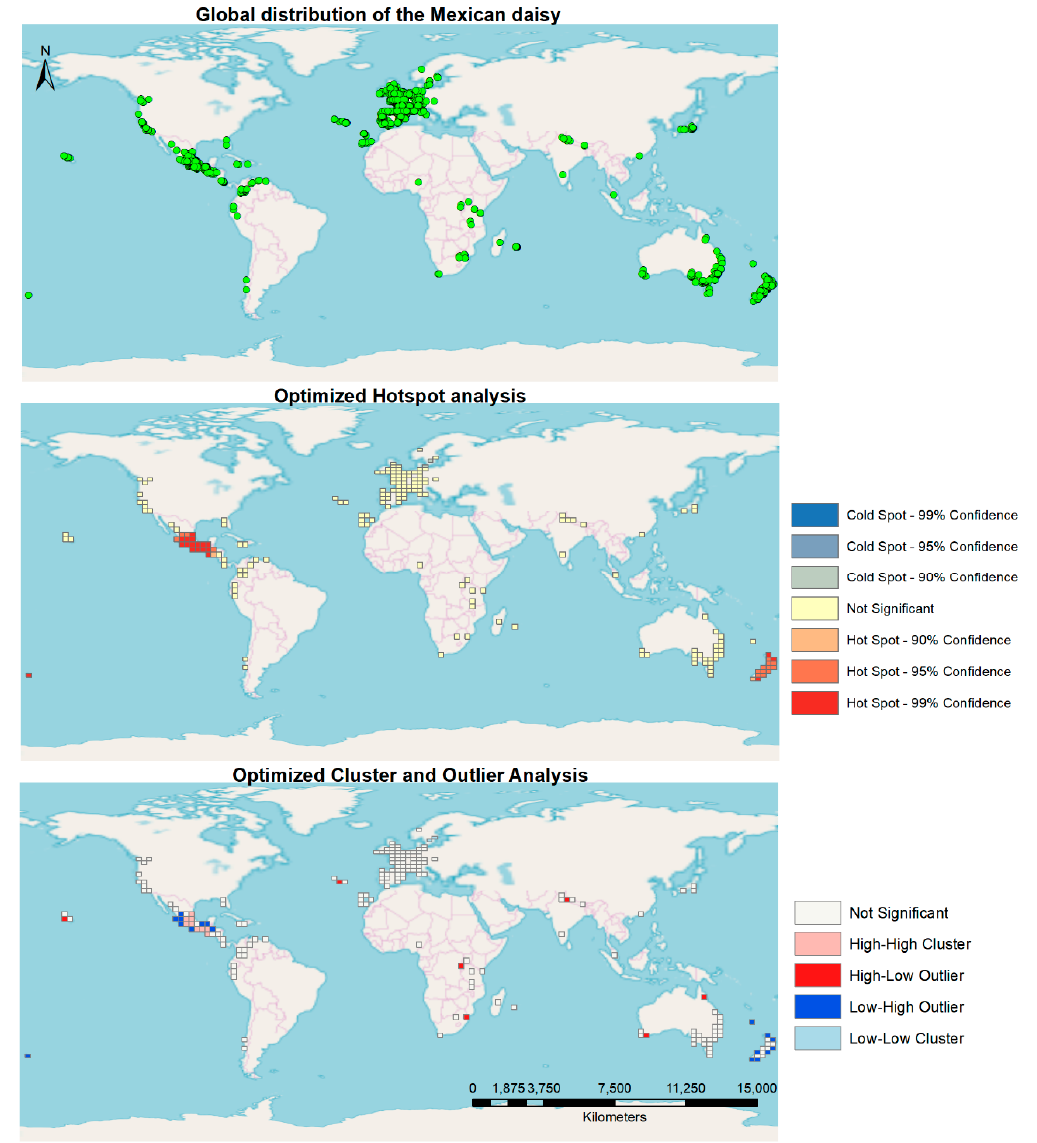
Figure 1. Worldwide occurrence of the Mexican daisy, using Hotspot and Cluster and Outlier Analysis.